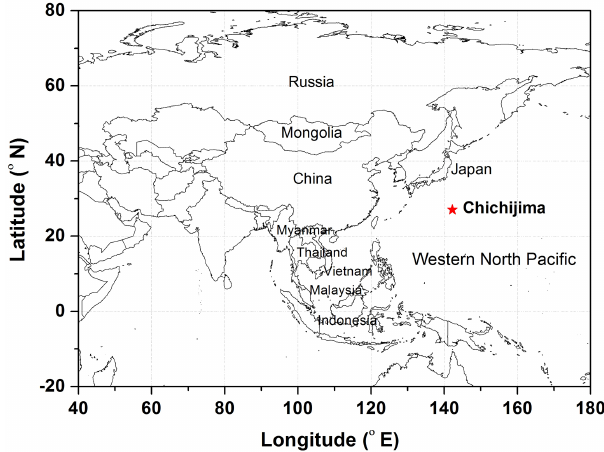
Figure 1. Location of sampling site (indicated by red star) in the western North Pacific and its adjacent Asian